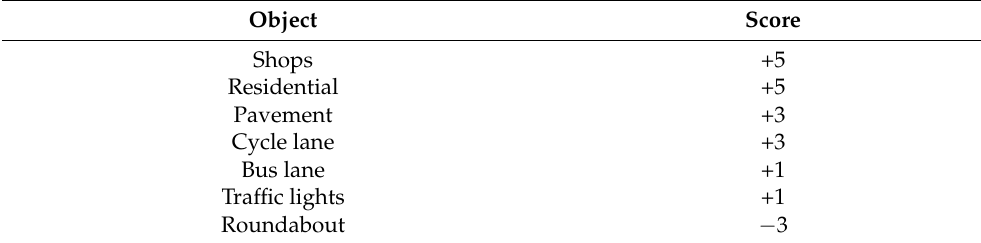
Table 2. Scores given for the presence of different types of scene elements within the view of a traffic camera, used to assess the camera’s potential to describe the ‘busyness’ of the local environment. Object Score Shops